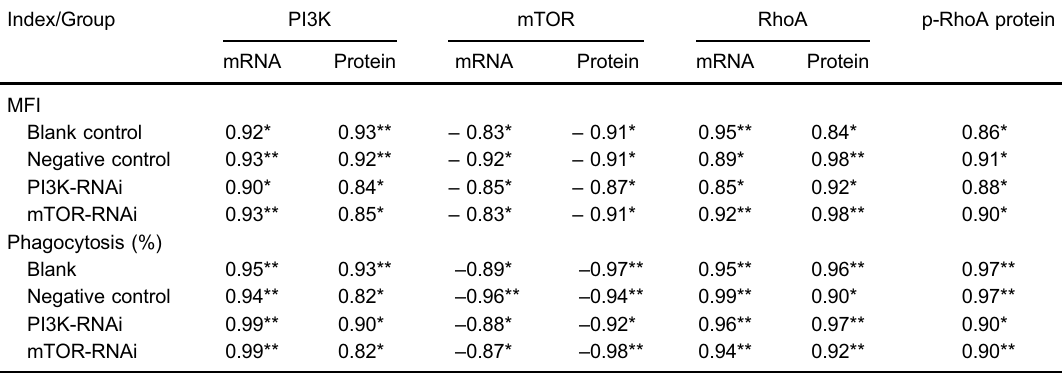
Table 4. Analysis of the correlation between mRNA and protein expression levels of PI3K, mTOR, RhoA, p-RhoA protein, and mean fl uorescence intensity (MFI) and percent phagocytosis (r